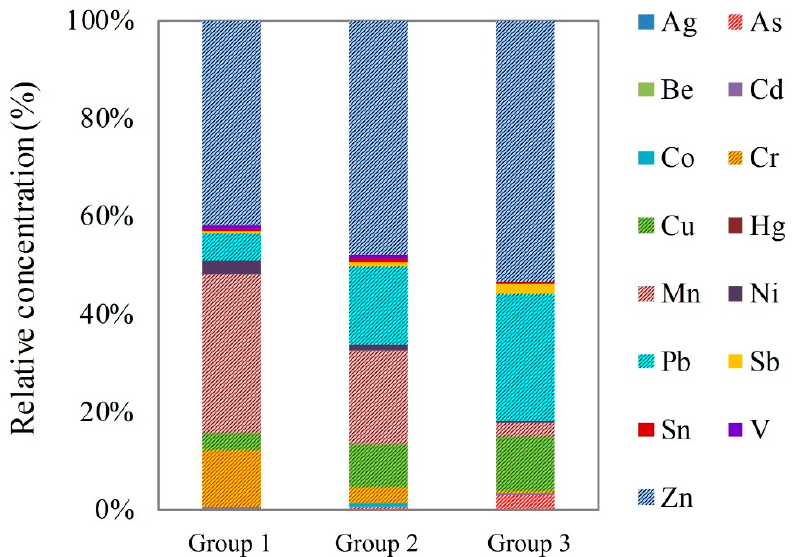
Figure 3. Heavy metal profile of PM10 in RDS from Group 1 (G1, steel industry sites), Group 2 (G2, fabricated metal industrial sites for automobiles and ship building, and petrochemical industrial sites), and Group 3 (G3, Onsan) (Non-ferrous smelting and petrochemical industrial